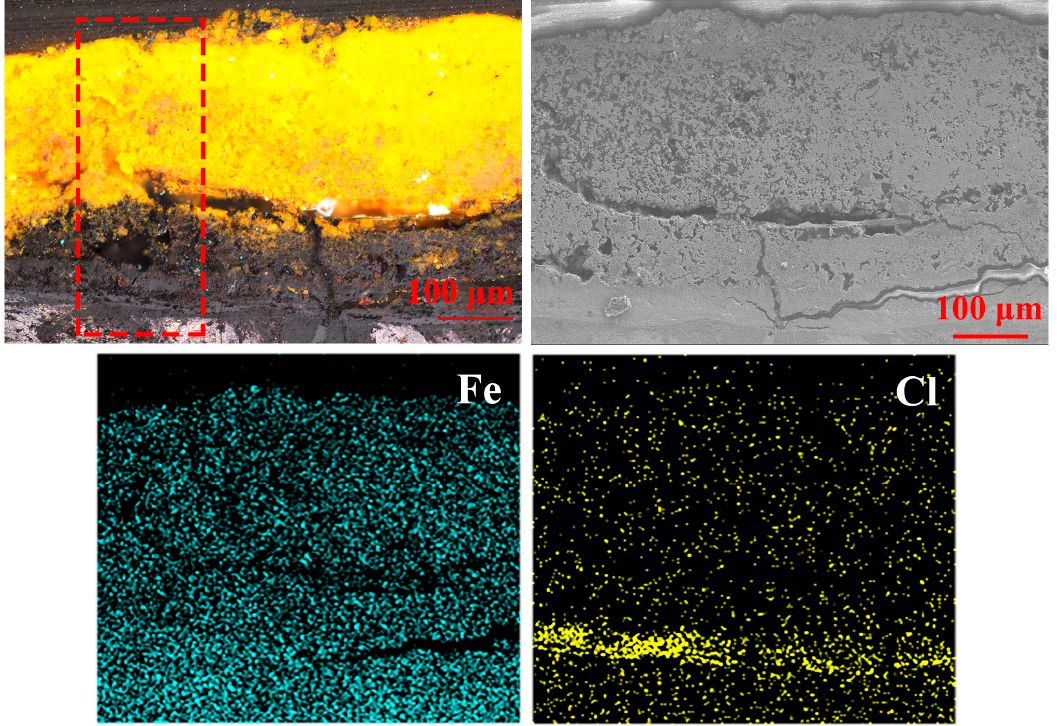
Figure 5. Graphs of the microstructure and element distribution of rust layer A (red square for Ra-man analysis).